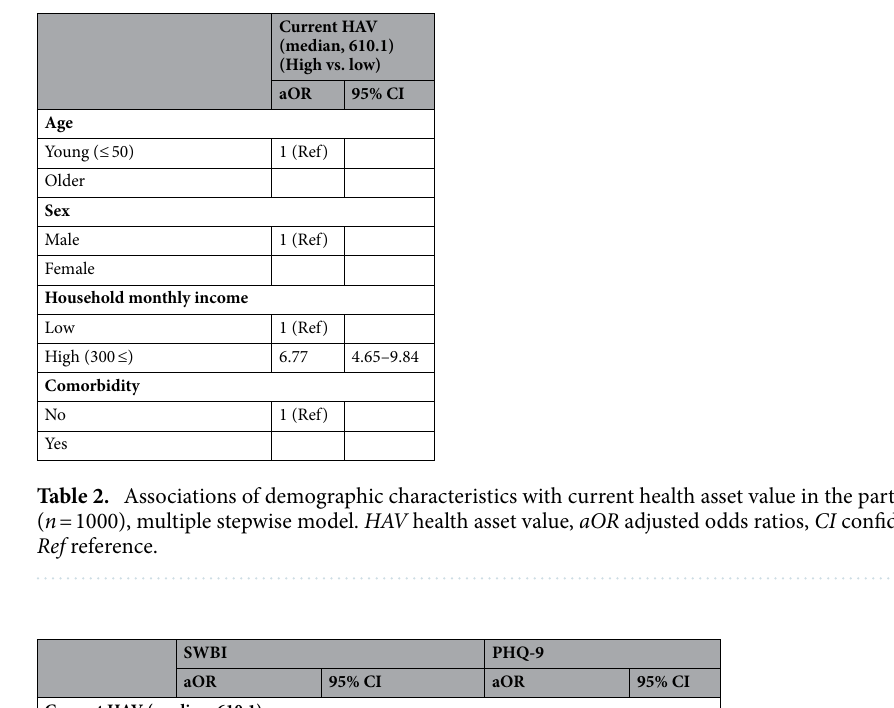
SWBI PHQ-9 aOR 95% CI aOR 95% CI Current HAV (median, 610.1) (high vs. low)